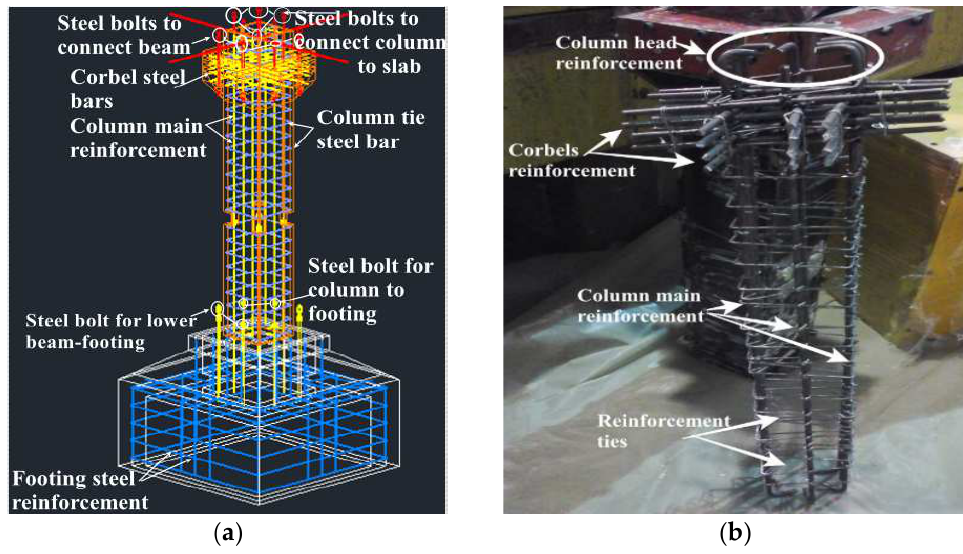
Figure 5. Column reinforcement details: ( a ) AutoCAD details; ( b ) actual column details. The scaled-down footing has three different 6 mm reinforcement bars